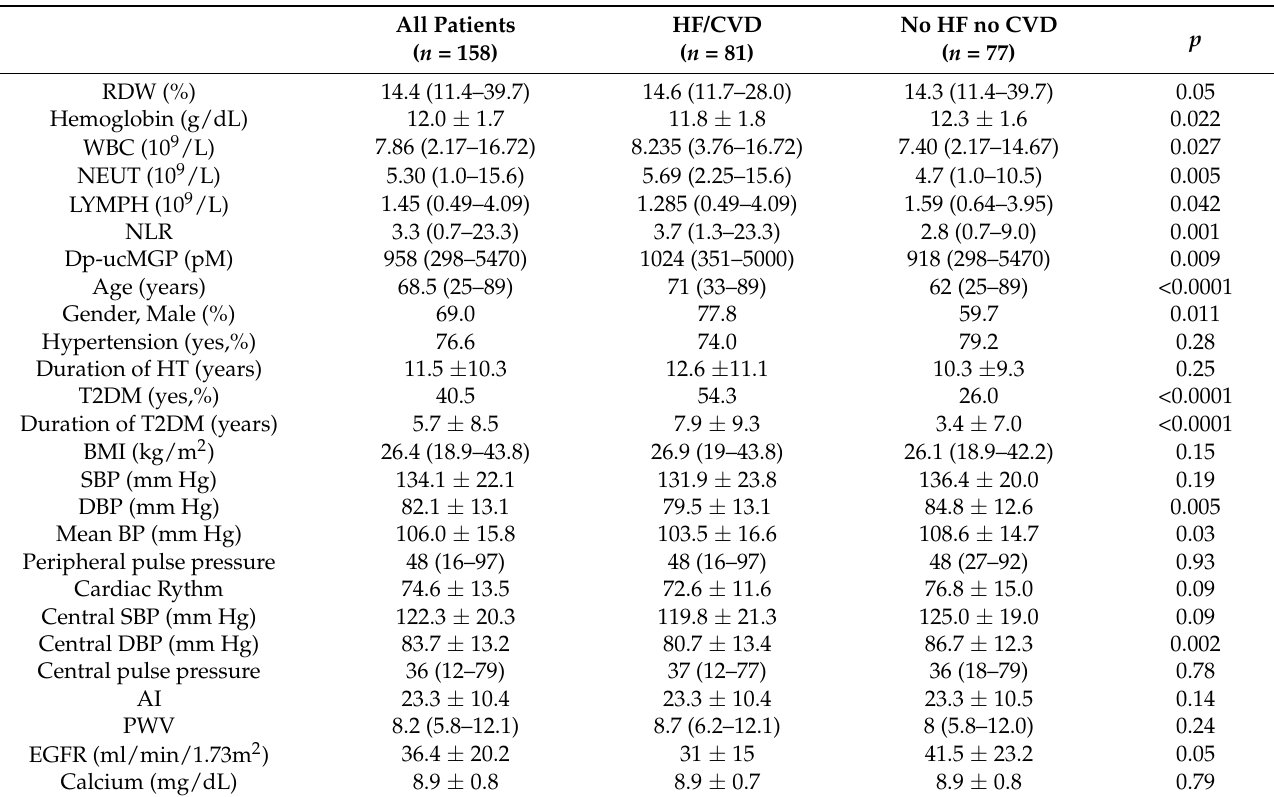
Table 1. Clinical, anthropometric and biochemical characteristics of chronic kidney disease patients with and without HF/CVD. Results for continuous variables are presented as median (range) or mean